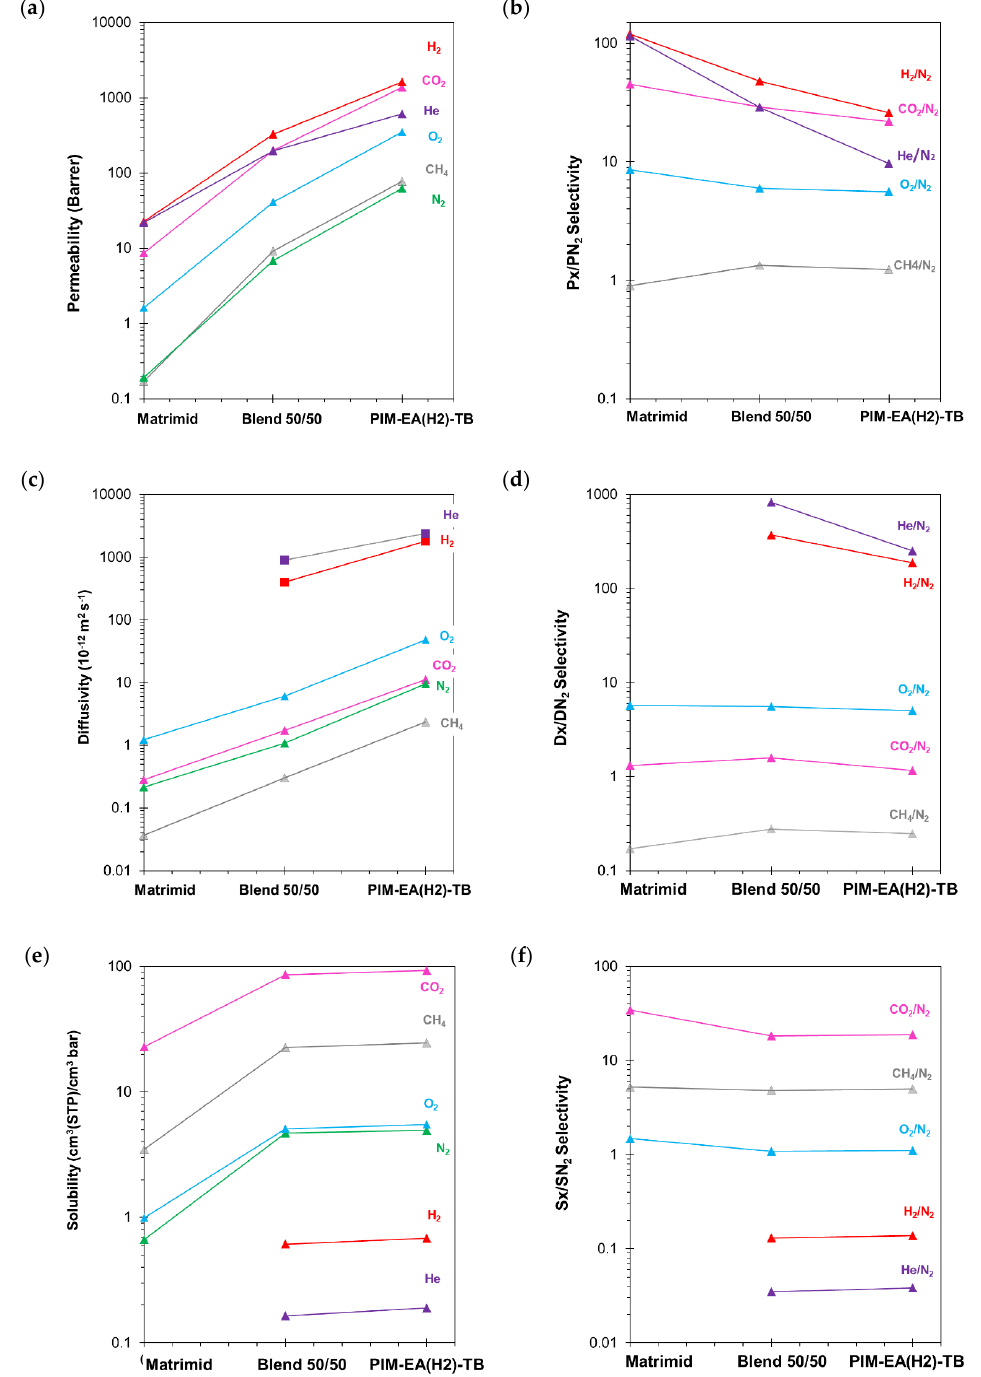
Figure 3. ( a ) Permeability, ( c ) diffusivity and ( e ) solubility coefficients with their respective selectivities ( b , d , f ) of Matrimid ® (100%); Matrimid ® 5218/PIM-EA(H 2 )-TB blend and PIM-EA(H 2 )-TB (100%). The lines are indicated as a guide to the